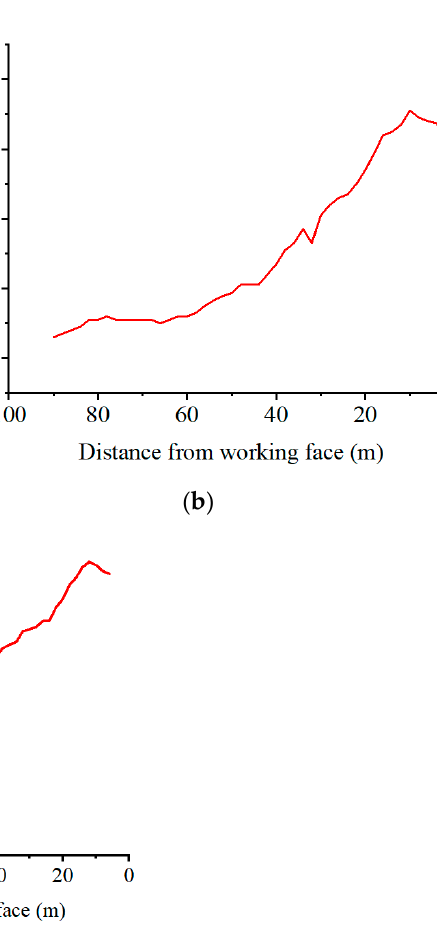
Figure 18. Effect of on-site delayed temporary support.